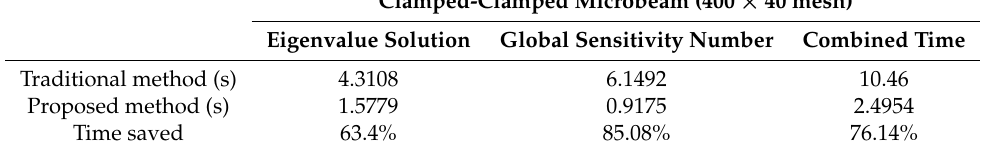
Table 1. The comparison of the average computational times of each iteration of topology opti- mization of the clamped-clamped microbeam resonator with the traditional linear method and the proposed method.